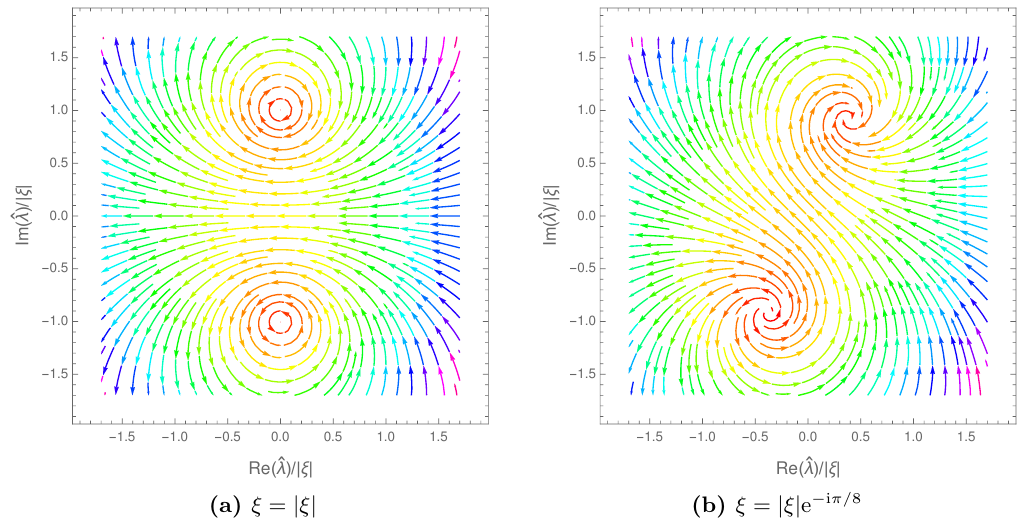
Figure 2. Phase portraits of the RG (cid:13)ow predicted by eq. (3.27) and (3.29) for nonzero complex (cid:24) . The left panel shows evolution when (cid:24) is imaginary (as appropriate, for black holes, when ! is real and s = 0), while the right panel shows the more general case where (cid:24) has both real and imaginary parts. Colour indicates the speed with which the (cid:13)ow occurs with red being slow and purple being